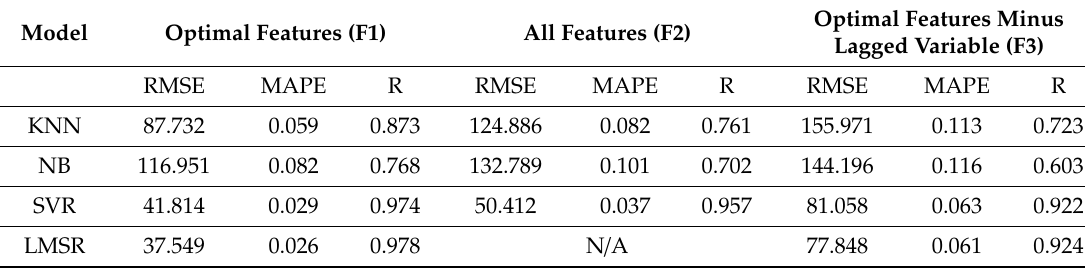
Table 5. Electricity modelling results from 2015 Apr–2017